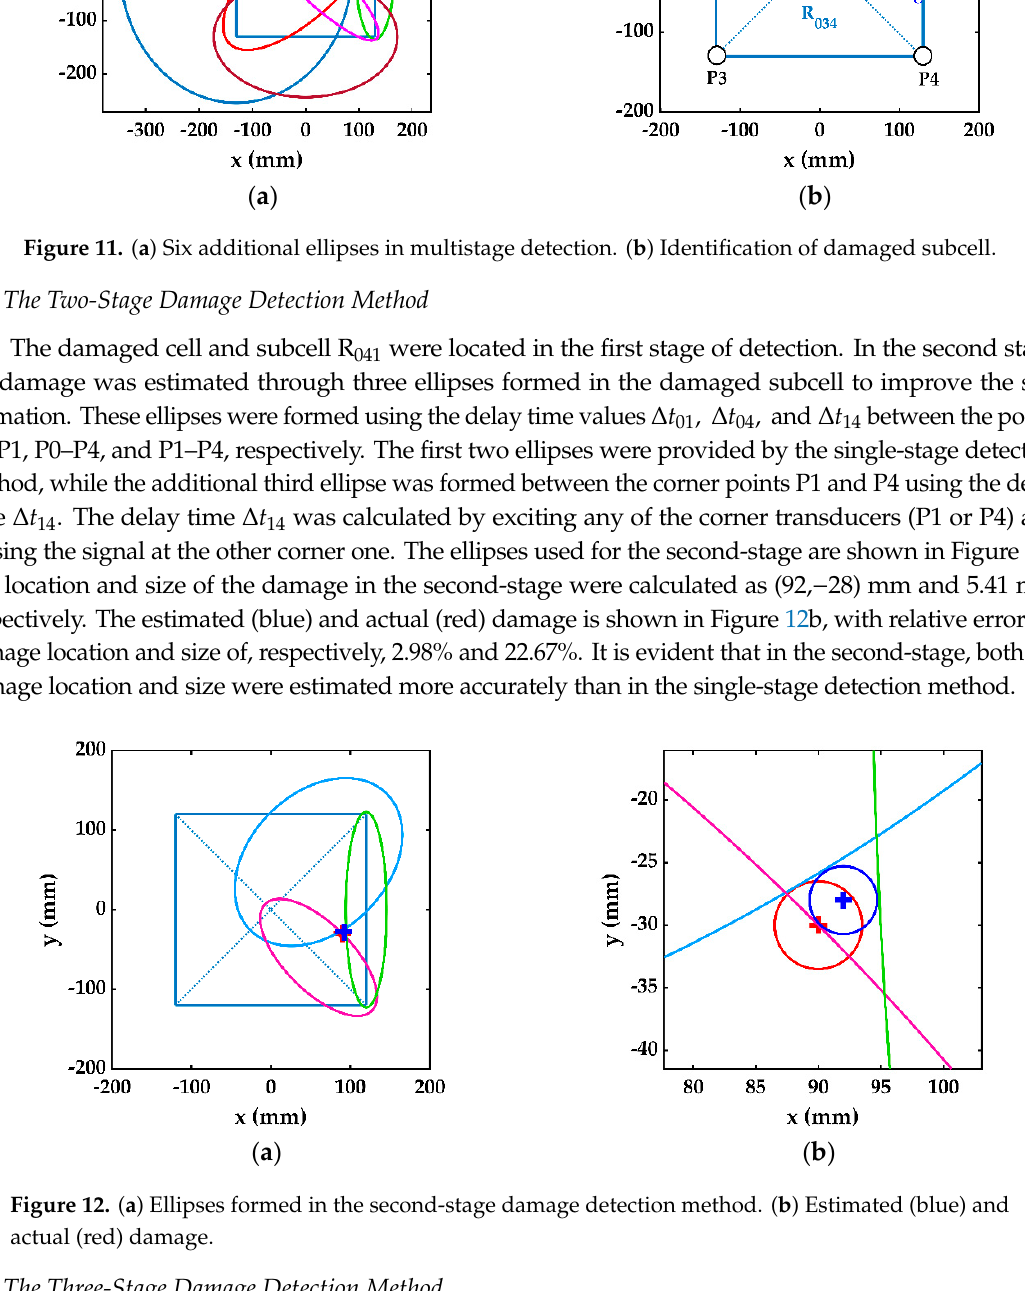
Figure 11. ( a ) Six additional ellipses in multistage detection. ( b ) Identification of damaged subcell.